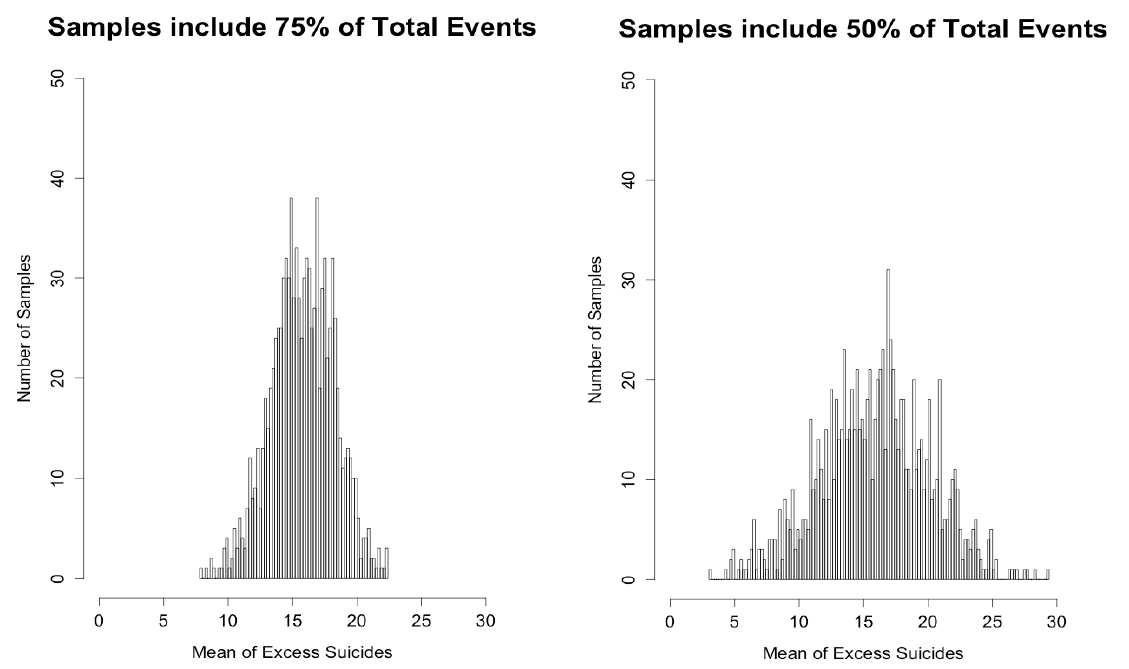
Figure 3: Robustness of effects for different samples of